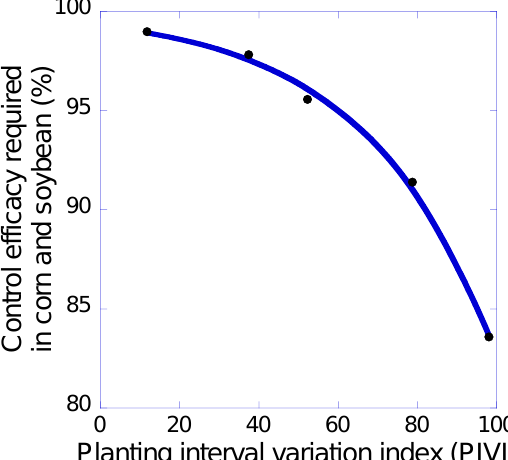
Figure 4. The relationship between planting interval variation index (PIVI) and the minimum level of control efficacy required in corn and soybean to prevent increases in giant ragweed seed density. As